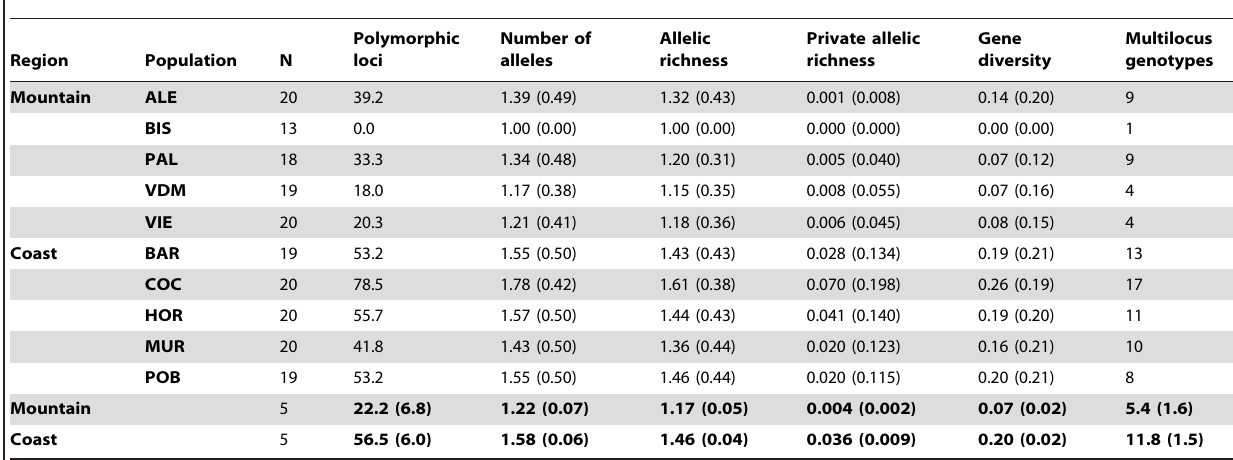
Table 4. Sample size and mean ( 6 SD) values for genetic diversity parameters of A. thaliana .